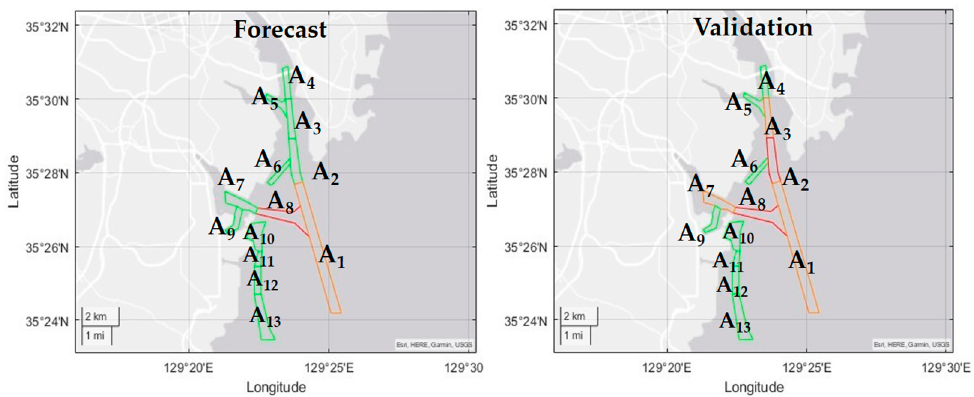
Figure 7. Ship congestion forecast results.